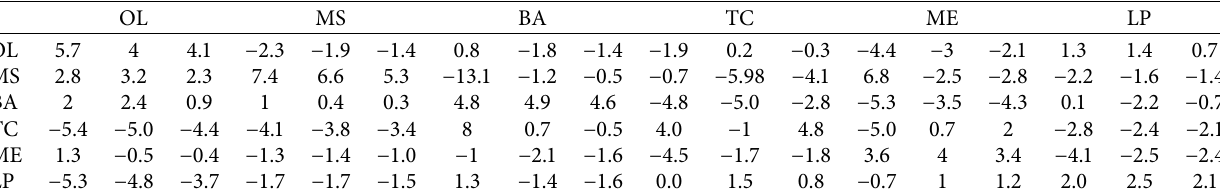
Table 5: Matrix of fuzzy total relationships.